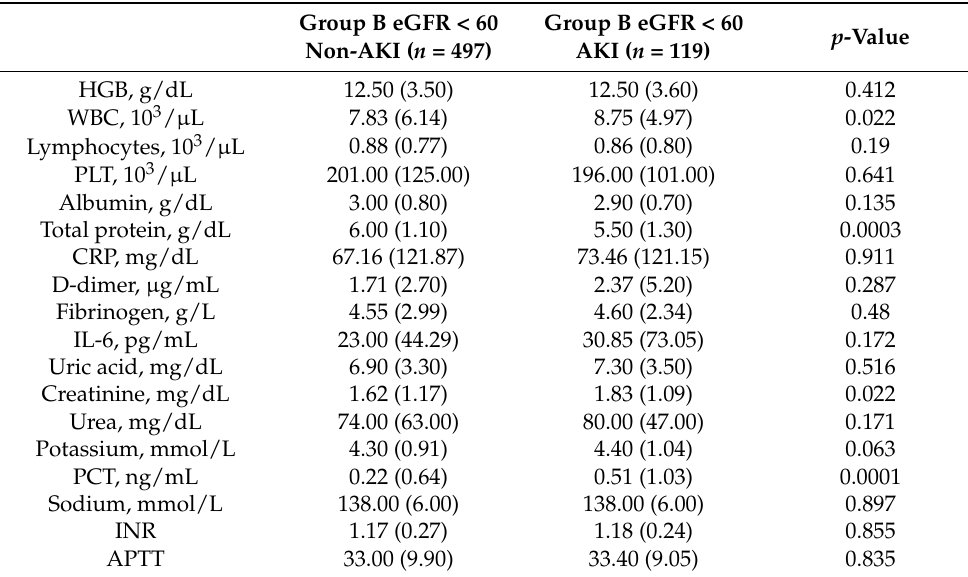
Table 12. Laboratory results of patients with eGFR < 60 mL/min/1.73 m 2 at admission without and with AKI during